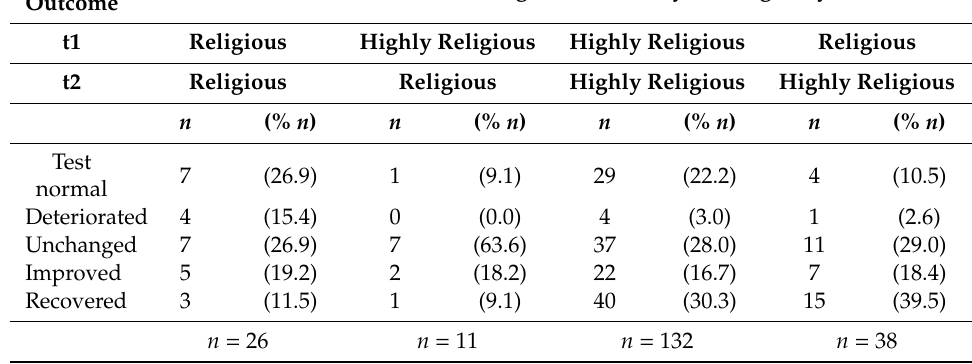
Table 5. Frequency distributions of changers and non-changers with respect to the centrality of religiosity from t1 to t2 regarding therapy